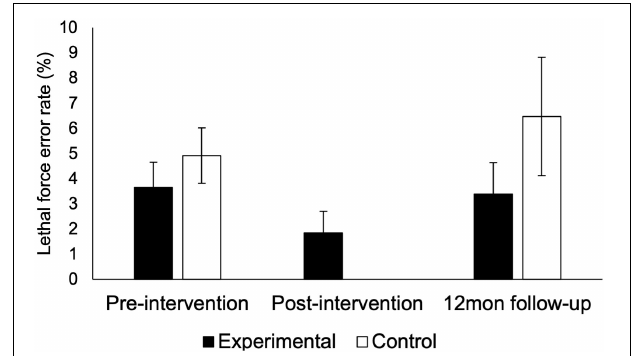
FIGURE 2 | Lethal force decision-making errors. Differences in lethal force error rates between groups and timepoints did not reach statistical significance. Error bars show standard error of the mean.